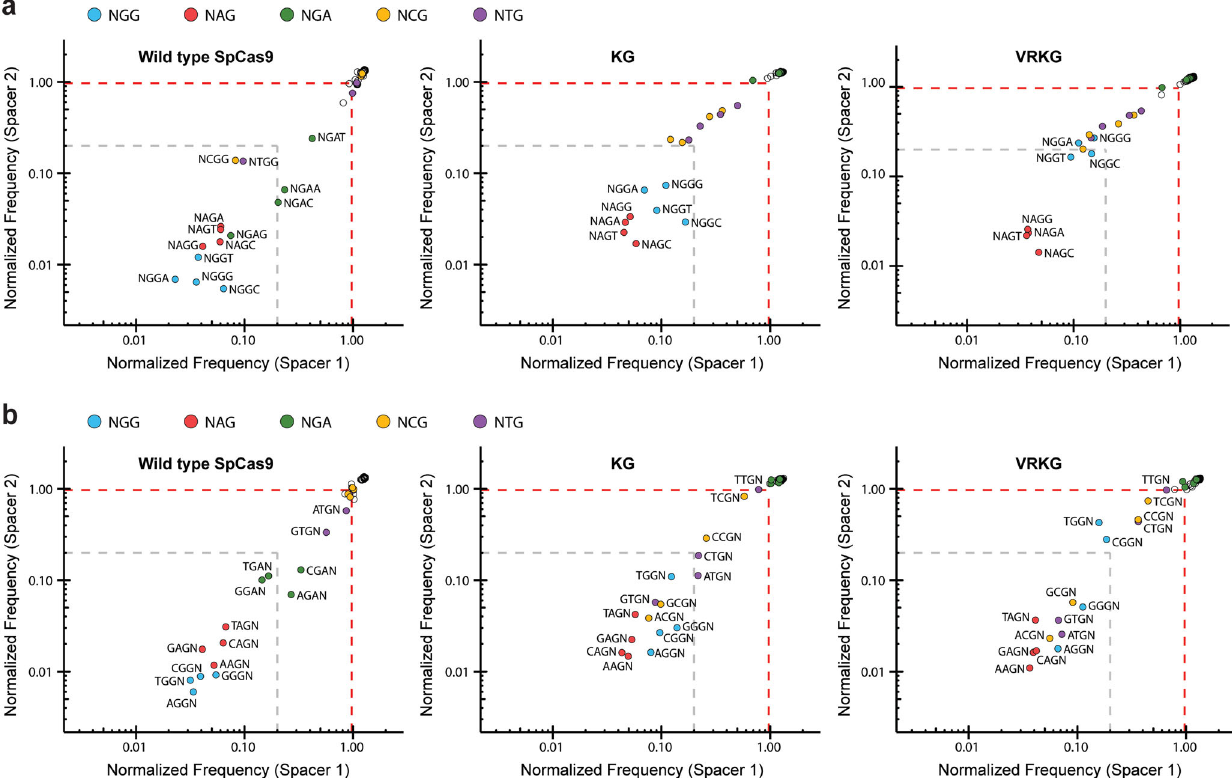
Fig. 4 PAM repertoire pro fi ling for the KG and VRKG variants. a Plasmid cleavage assays with a randomized PAM library. Wt, KG, or VRKG Cas9 plasmids programmed with a targeting spacer in their sgRNA scaffold (Spacer 1 or Spacer 2) were co-delivered with the PAM library and plated with 10 µ M IPTG and antibiotics to select for both plasmids. After deep sequencing, PAM frequencies were calculated for each pool of double transformants and normalized to their frequencies in the pre-depletion PAM library. For each spacer ( X or Y axis), normalized PAM frequencies were plotted with binning for all possible sequences at PAM positions two through four. Gray dashed lines denote a normalized frequency value of 0.2 ( fi vefold depletion). Red dashed lines denote a normalized frequency value of 0.977; none of the normalized frequency values from Wt dCas9 control experiments with either spacer were lower than 0.97 when rounded to the nearest hundredth (Supplementary Data 1). b Same data from experiments in panel a , but re-plotted with binning for all possible sequences at PAM positions one through three. Source data are available in the Source Data fi